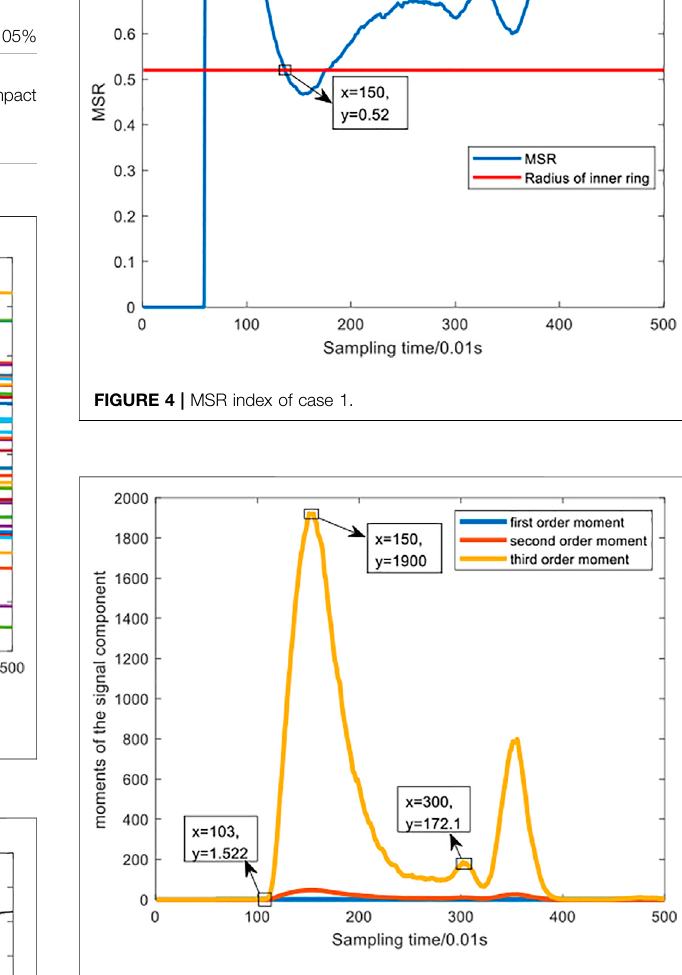
FIGURE 5 | Moments of the signal component in case